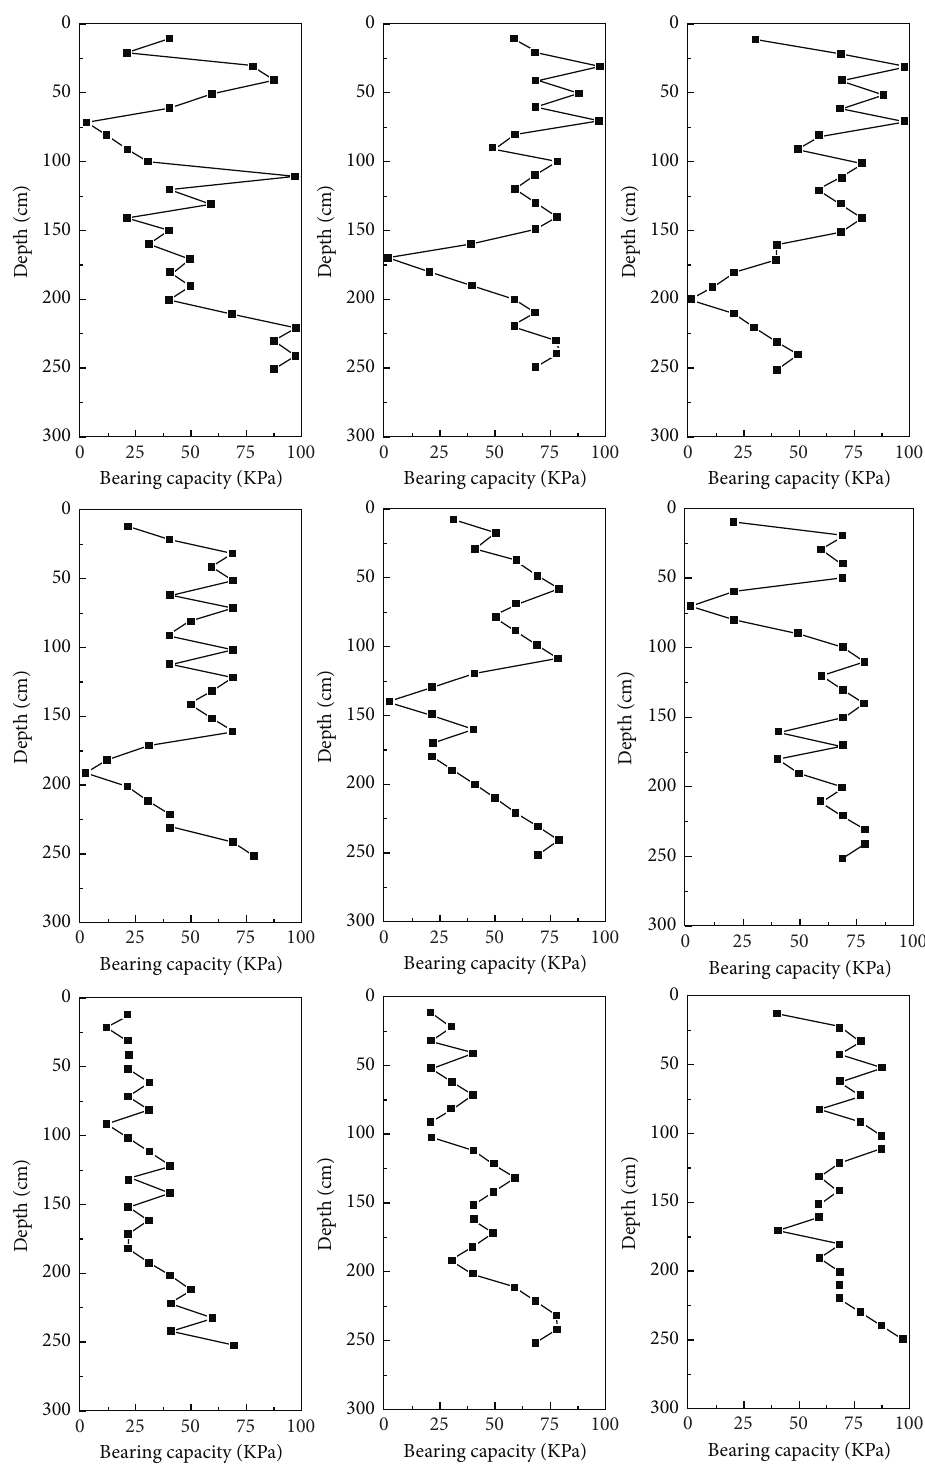
Figure 3: Results of the simple penetration test on the 9 detection